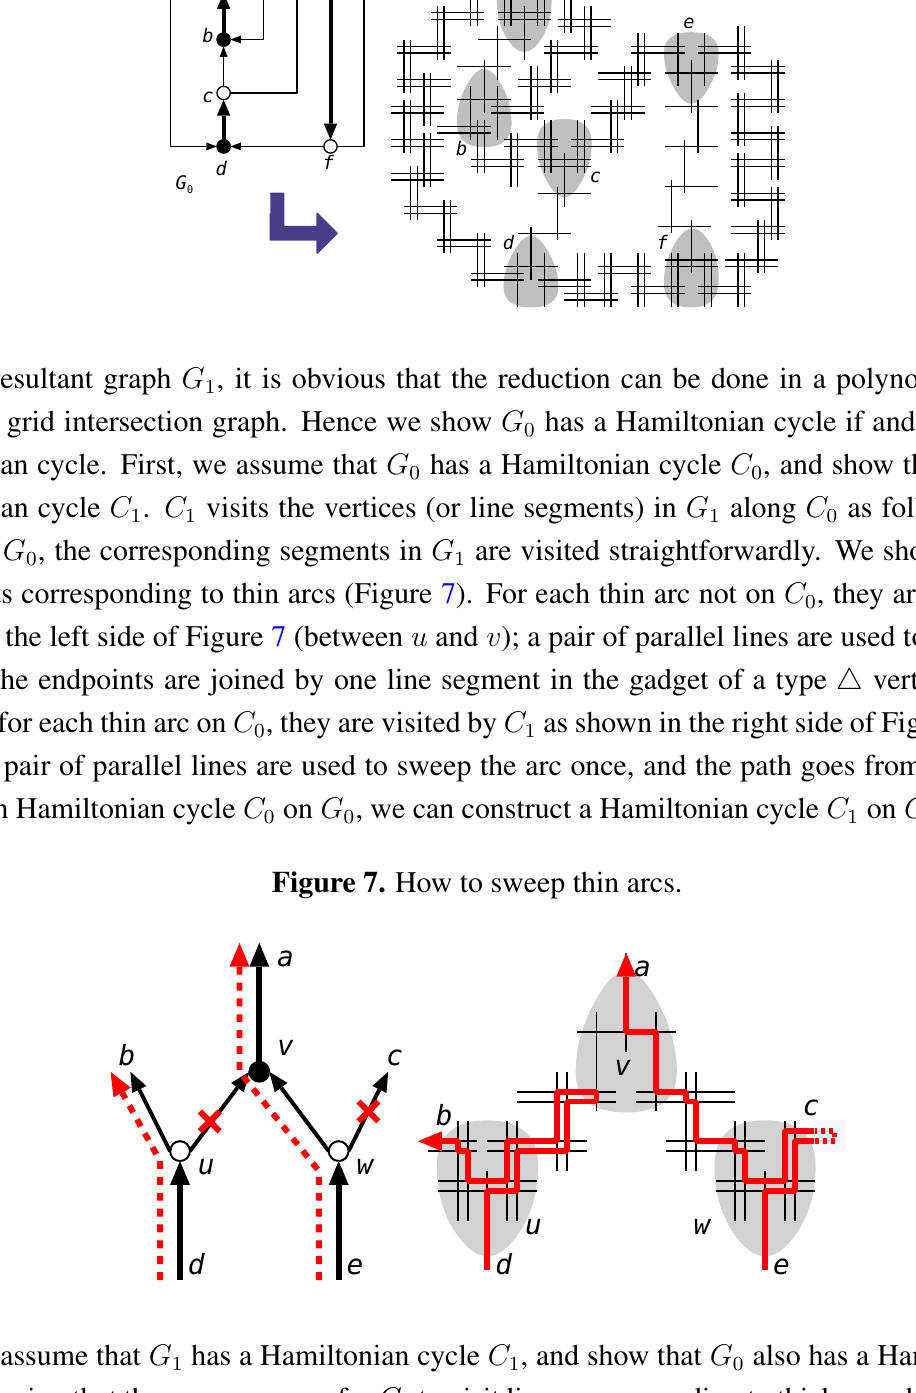
Figure 6. Reduction of a graph G